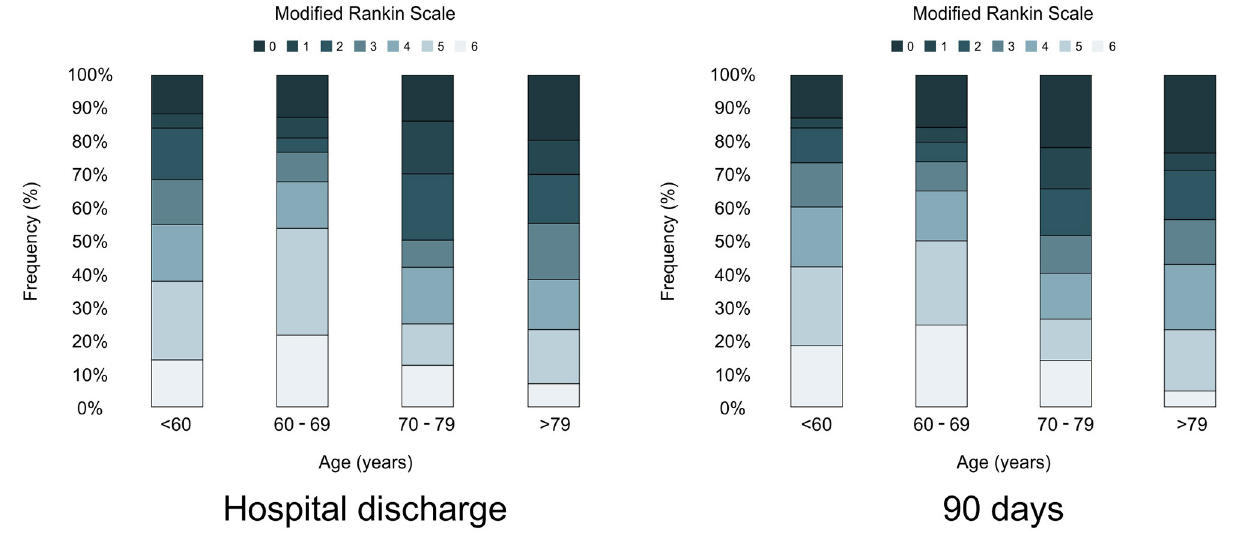
FIGURE 2 | Frequency of modified Rankin scale in each aging group at hospital discharge and 90-days after